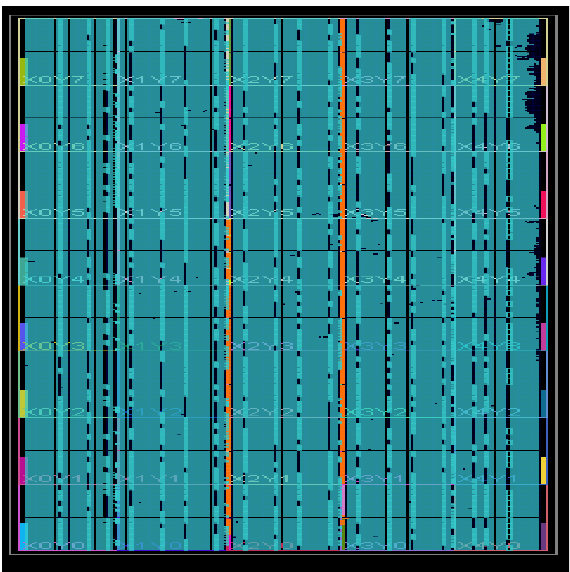
Figure 6. Routed Floorplan of FPGA Example 4 design, which consists of around 67k